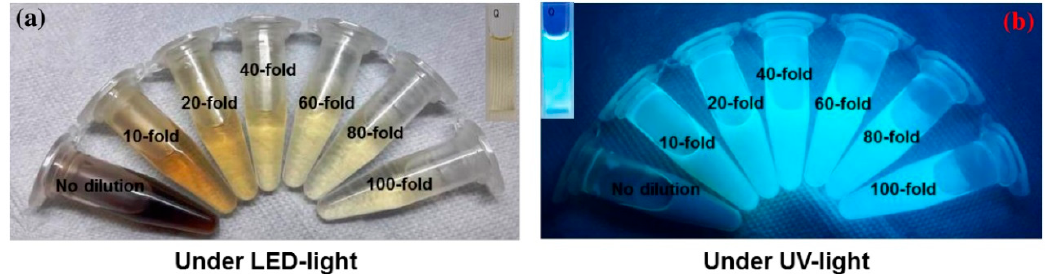
Figure 6. The appearance of AC-NCDs with various dilution factors under irradiation of ( a ) LED-light and ( b ) UV-light.